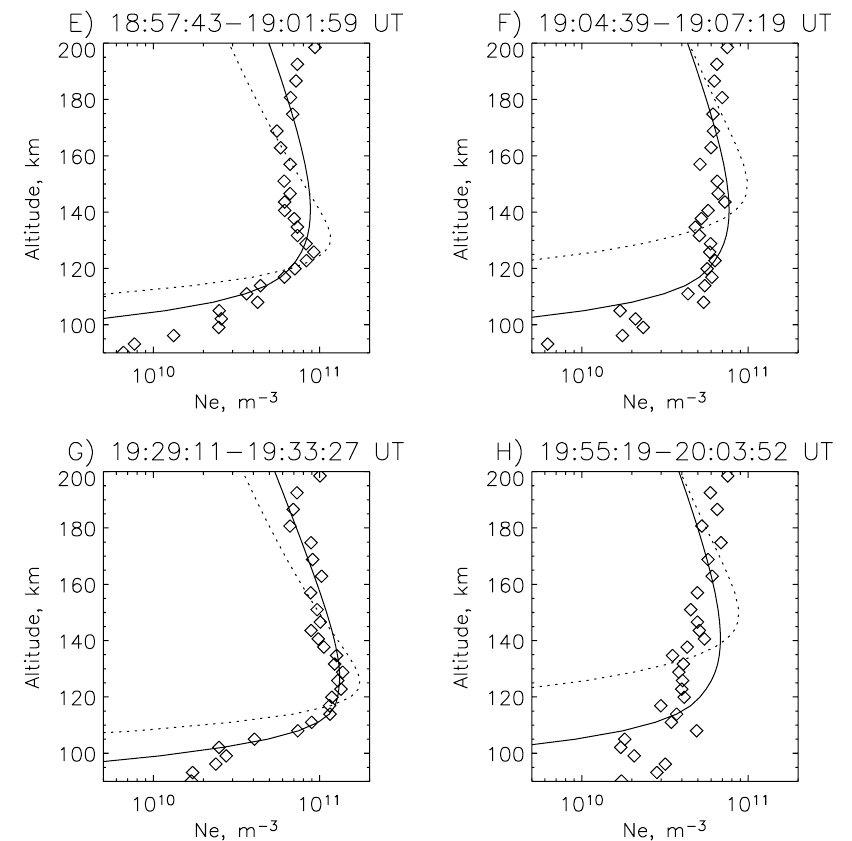
Fig. 12. ESR density profiles and SIF spectra for intervals E, F, G and H in Fig. 10.